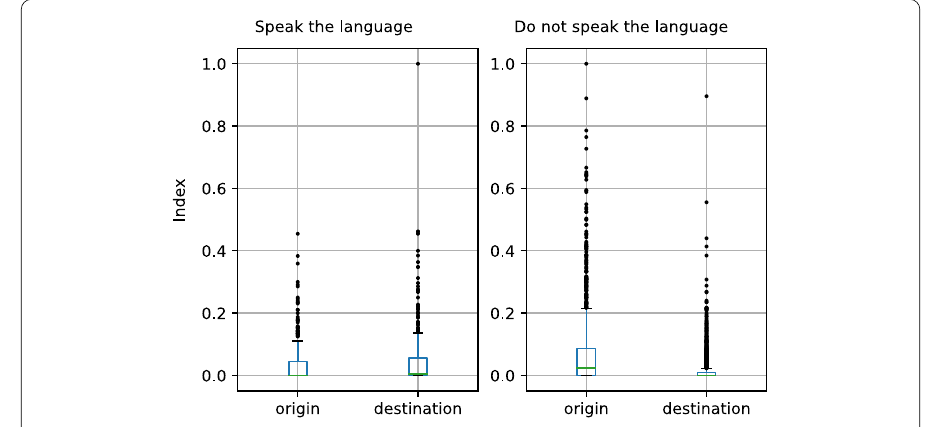
Figure 6 Box plots showing the OA and DA distributions for a group of migrants who speak the language of the host country on the left and a group of migrants who do not speak the language of the host country on the right. Means are ¯ OA = 0.034 and ¯ DA = 0.041 for users who speak the destination language, and ¯ OA =